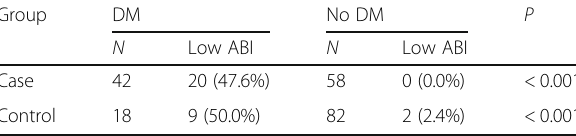
Table 3 Comparison of percent frequency for abnormal ABI in subjects with or without HTN in case and control